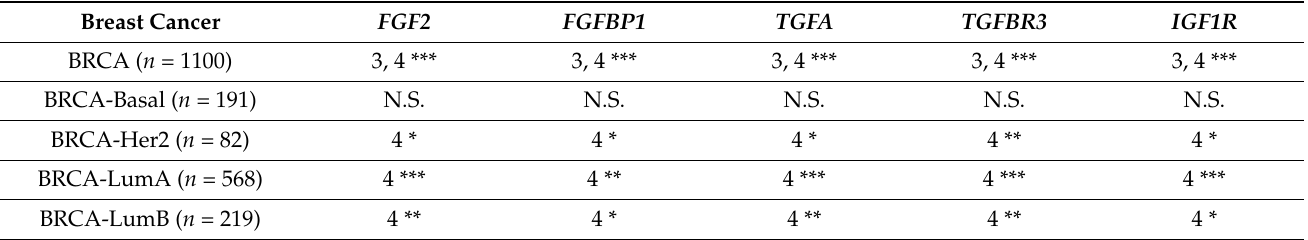
Table 1. Gene expression and the clinical stage factors across various breast cancer